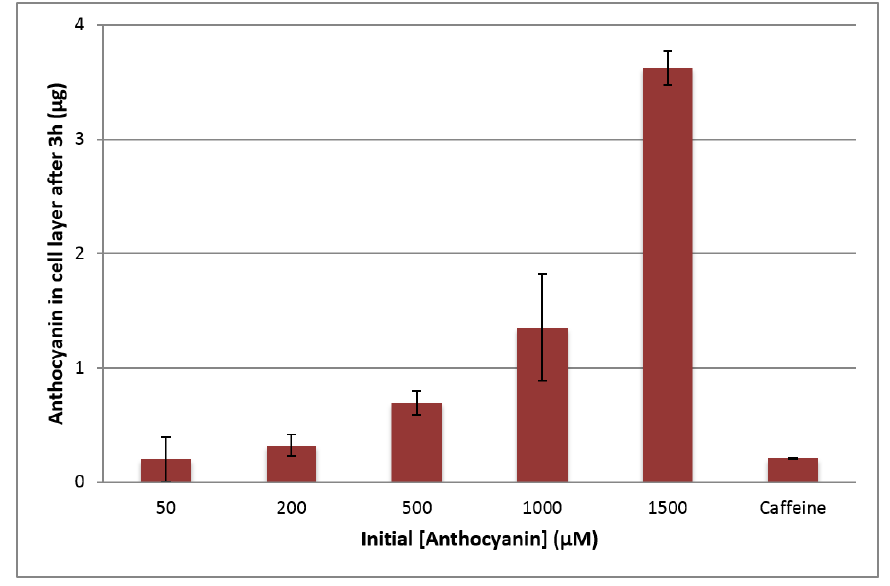
Figure 4. Effect of initial anthocyanin concentration (µM) on the total anthocyanin amount (µg) extracted from the NCI-N87 cell layer after 3 h treatment at 37 °C at apical pH 3.0 and basolateral pH 7.4. Initial caffeine concentration was 1500 µM.